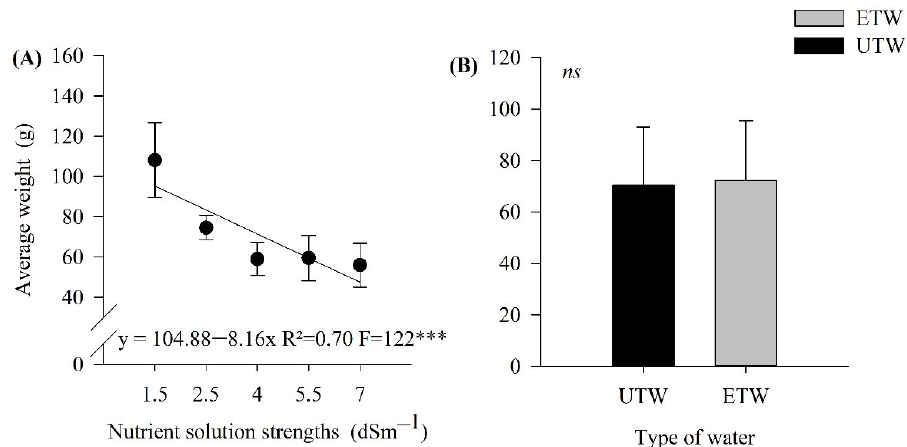
Figure 3. The average weight of the tomato crop fruits submitted to different strength nutrient solution with electromagnetically treated water (ETW) and untreated water (UTW), ( A ) effect only of the different strength nutrient solution, ( B ) effect of the type of water used in irrigation. The error bars indicate the standard deviation of the average of four repetitions ( n = 4). ns: not significant, *** significant at 1%.